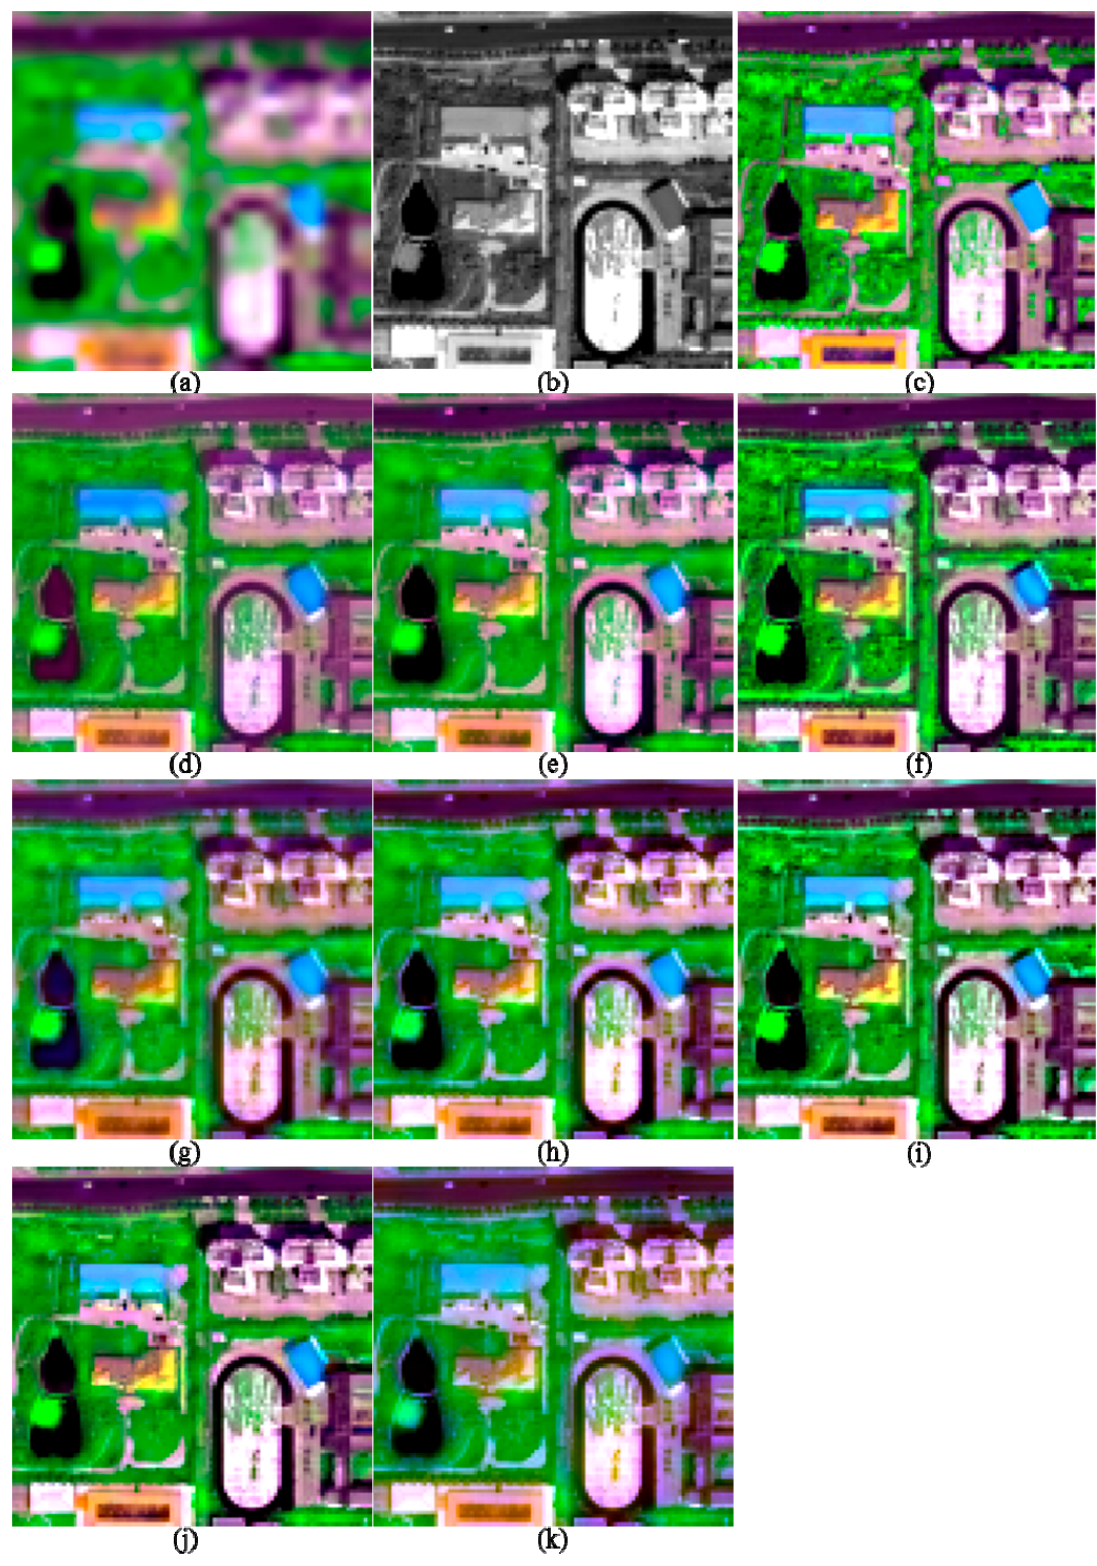
Figure 6. The original and 2-m fused images of I4, shown in band 5-7-2 composition. ( a ) 8-m MS; ( b ) 2-m PAN; ( c ) True 2-m MS; ( d ) GS; ( e ) GSA; ( f ) HR; ( g ) HCS; ( h ) ATWT; ( i ) GLP_ESDM; ( j ) GLP_ECBD; and ( k ) NSCT_M2.